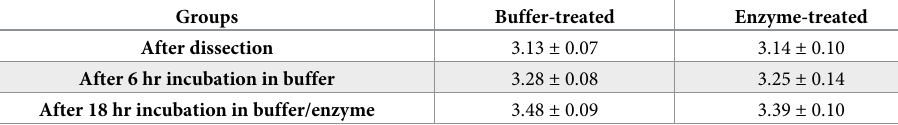
Table 2. Hydration, in mg wet tissue weight / mg dry tissue weight, variations of porcine posterior disks during the experimental protocol, see Fig